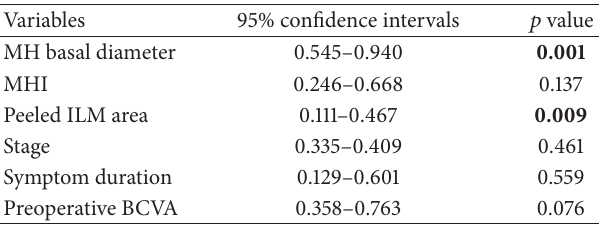
Table 3: Multiple regression model of variables associated with anatomical